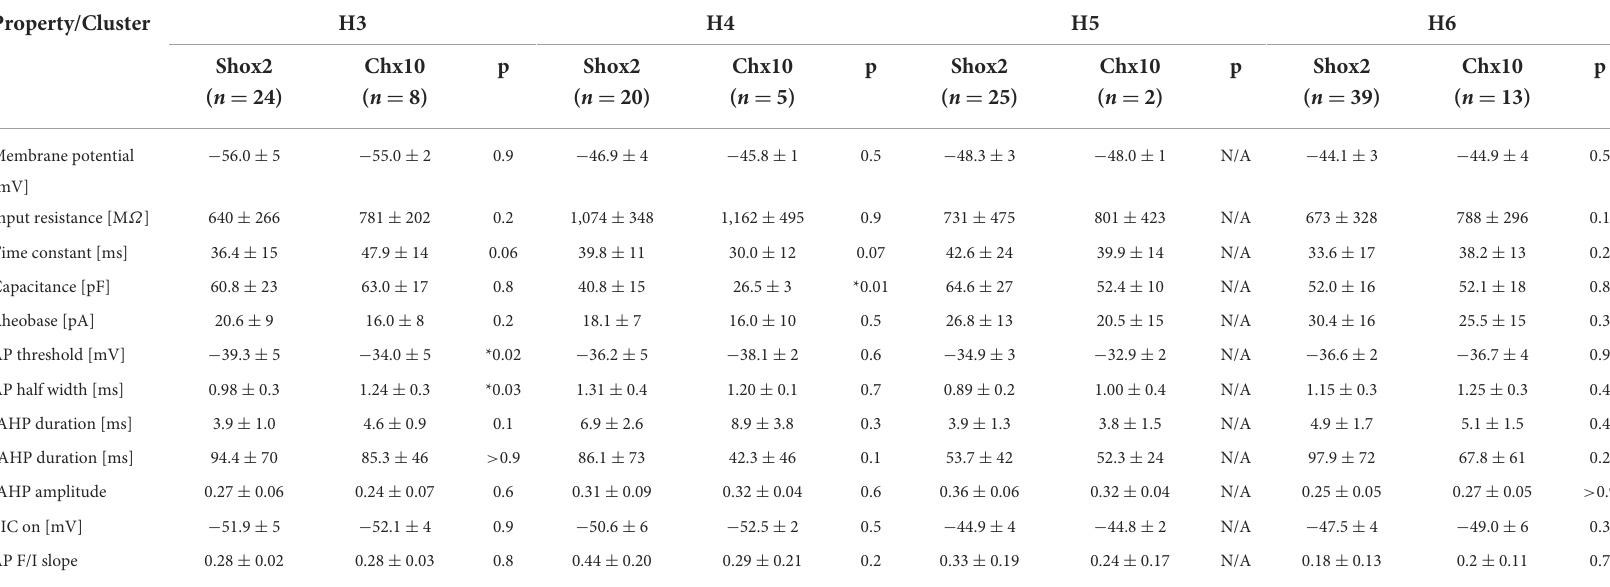
TABLE 3 Comparison of properties of Shox2 and Chx10 neurons in each of the hierarchical clusters.